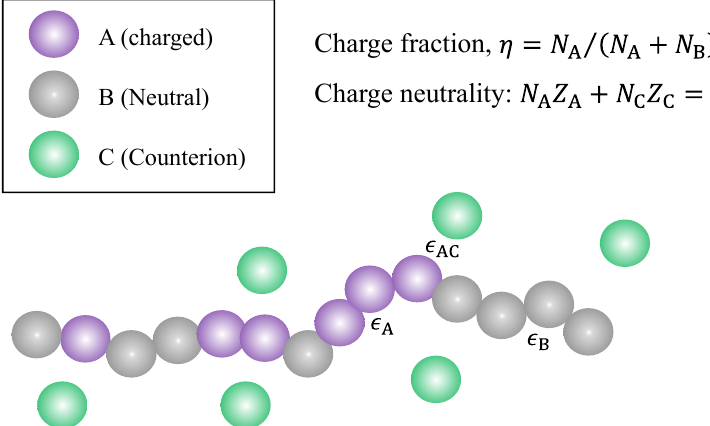
Figure 1. Illustration of a partially charged polymer with total length N , a sum of the charged ( N A ) segments (type A) and neutral ( N B ) segments (type B) and its counterions (type C). There are short-range interactions between A and C, between A and A, and between B and